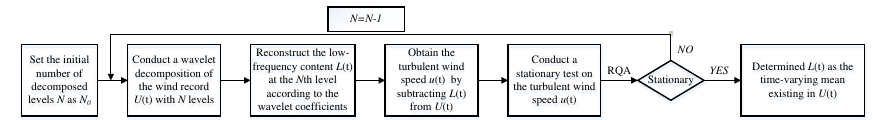
Fig. 3 General framework of self-adaptive approach to determining time-varying mean wind